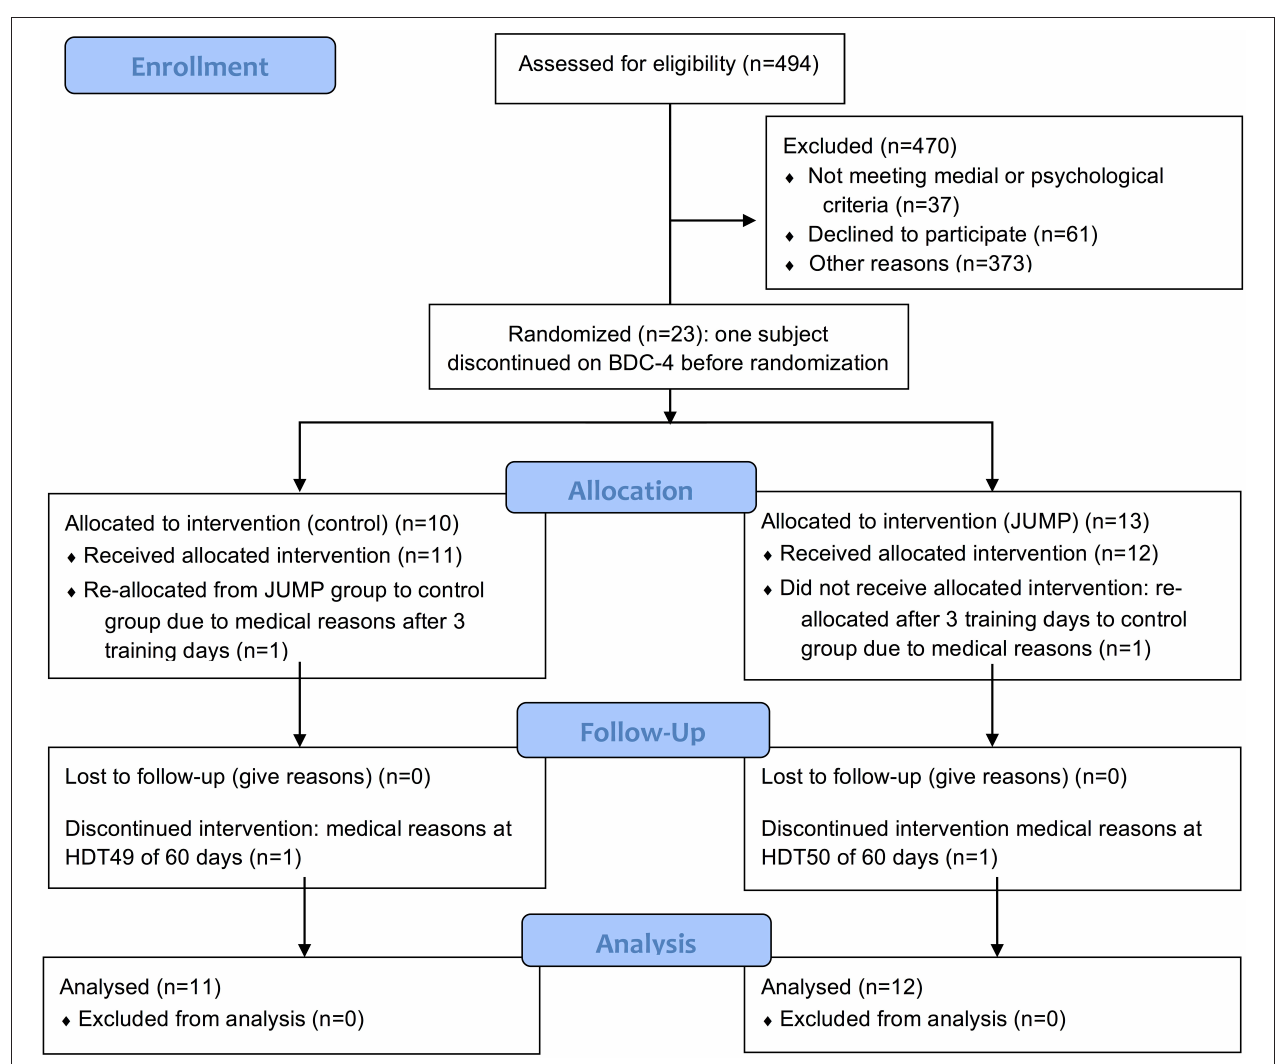
FIGURE 1 | CONSORT Flow diagram of the progress through the phases of a parallel randomized trial of the CTRL and JUMP groups split into the enrolment, intervention allocation, follow-up, and data analysis from the top to the